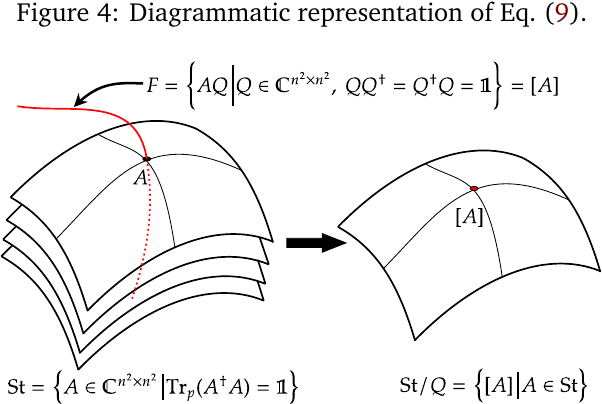
Figure 5: Graphical representation of the transition from the manifold St of all ma- trices A , to the quotient manifold St / Q that eliminates undesirable symmetry of the parametrization. The red curve represents a particular equivalence class F that is also called a